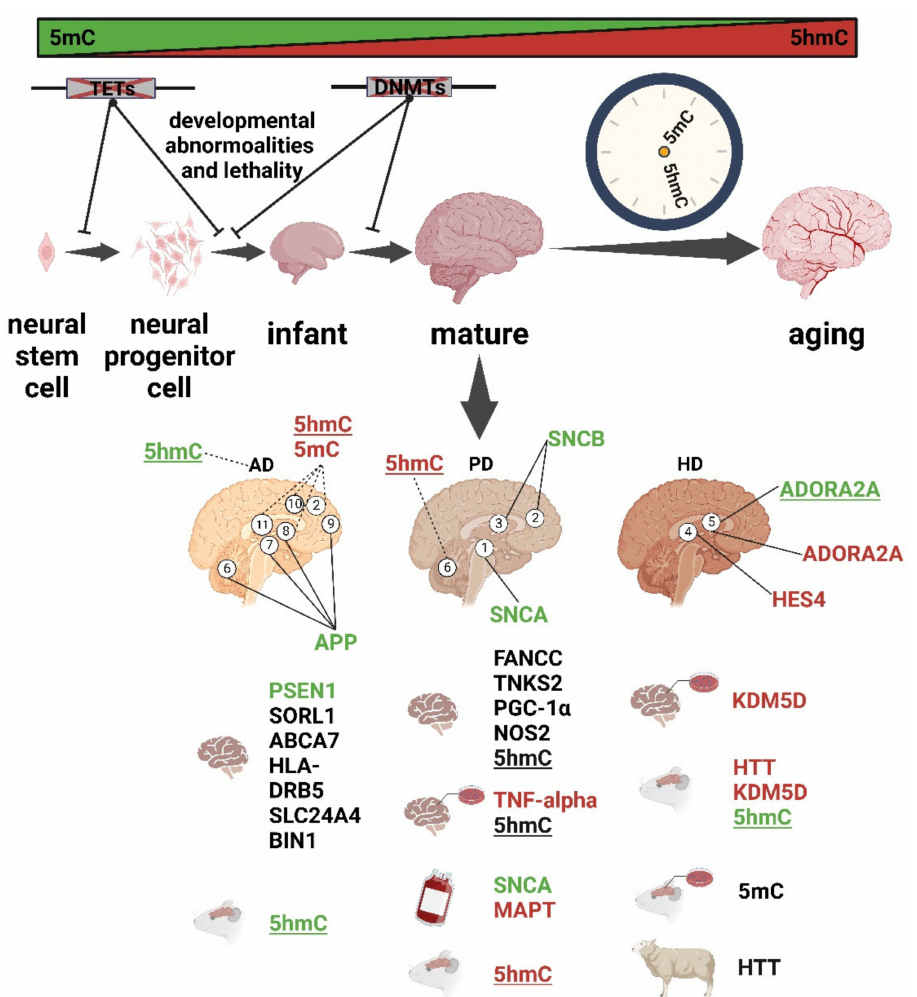
Figure 2. Summary of dynamic 5mC and 5hmC in development and aging and their abnormalities in neurodegenerative diseases (AD, PD, and HD). Green, hypomethylation; red, hypermethyla- tion; dashed line, the conclusion is controversial. Different brain regions are numbered as follows: 1. substantia nigra, 2. frontal cortices, 3. temporal cortices, 4. striatum, 5. putamen, 6.